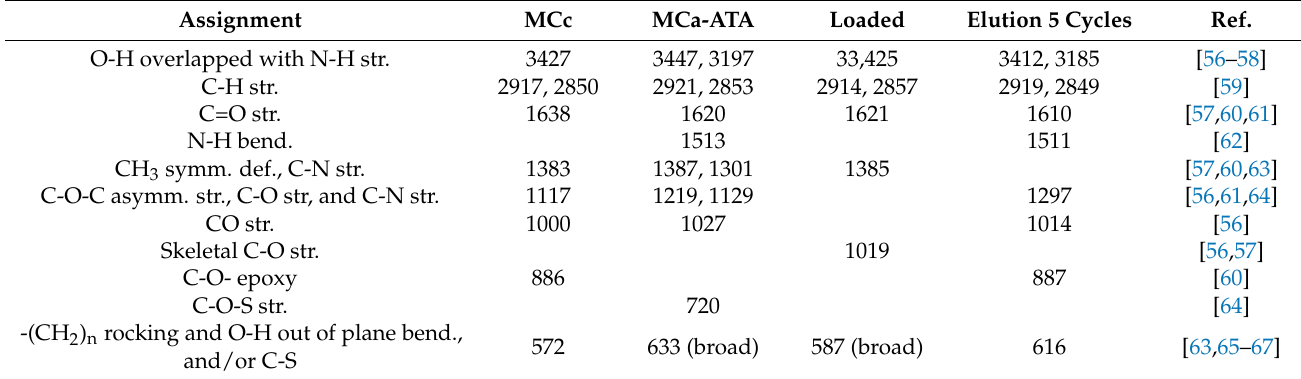
Table 1. Assignments of FTIR peaks for MCc and MCa-ATA before and after sorption and after five cycles of sorption desorption for Pb(II).